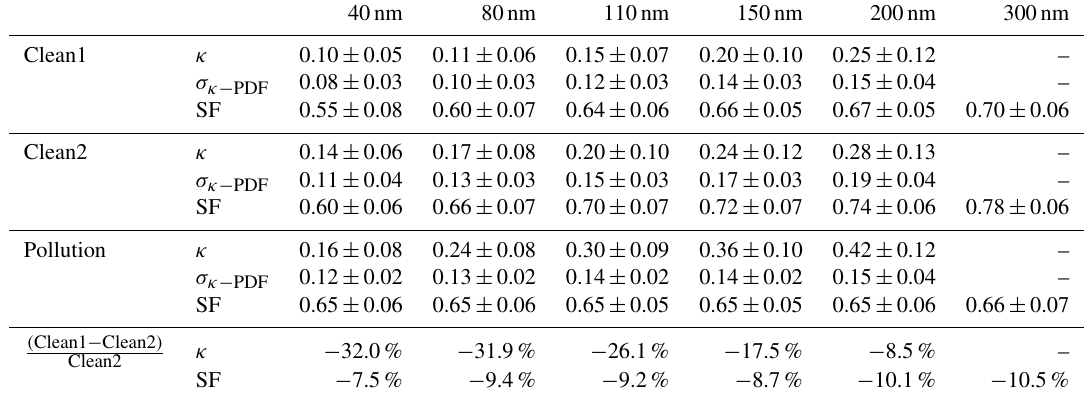
Figure 6. Diurnal variation of (a) mean SF (SF mean ) for different mobility diameters, (b) SF-PDF for particles with D p equal to 40nm, and (c) SF-PDF for particles with D p equal to 150nm during the Clean1, Clean2, and Pollution periods. Table 1. Summary of size-resolved mean κ , the κ -PDF growth spread factor ( σ κ − PDF ) , size-resolved mean SF during the selected three periods, and the change in percentage of κ and SF during the control Clean1 period compared with the non-control Clean2 period.